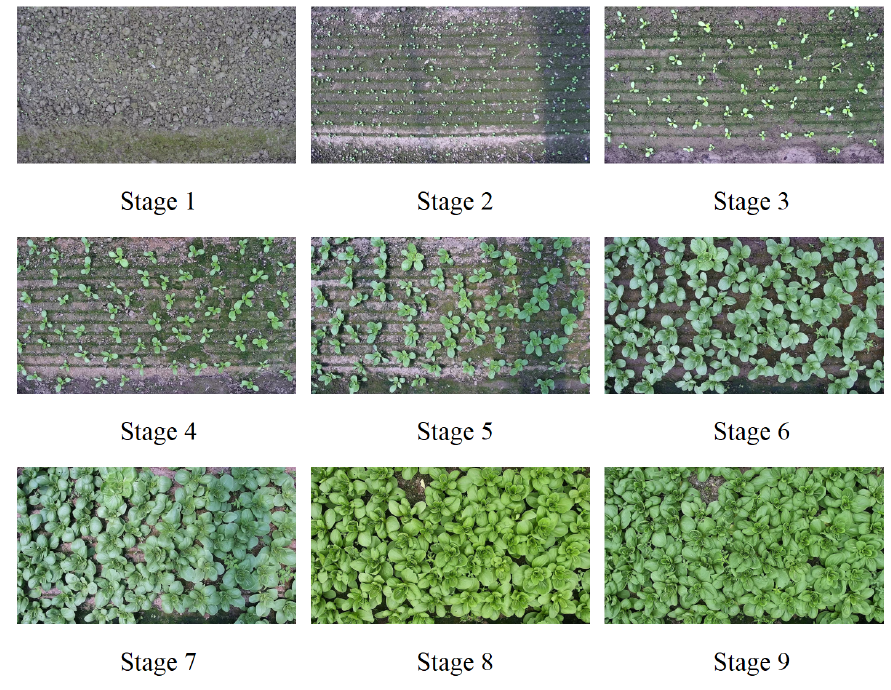
Figure 2. Images of leafy greens in different growth stages.